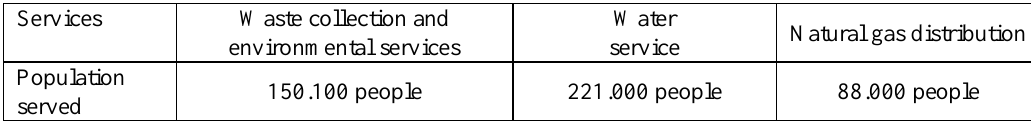
Table 2: Services provided and Population Served by ASPEM Services